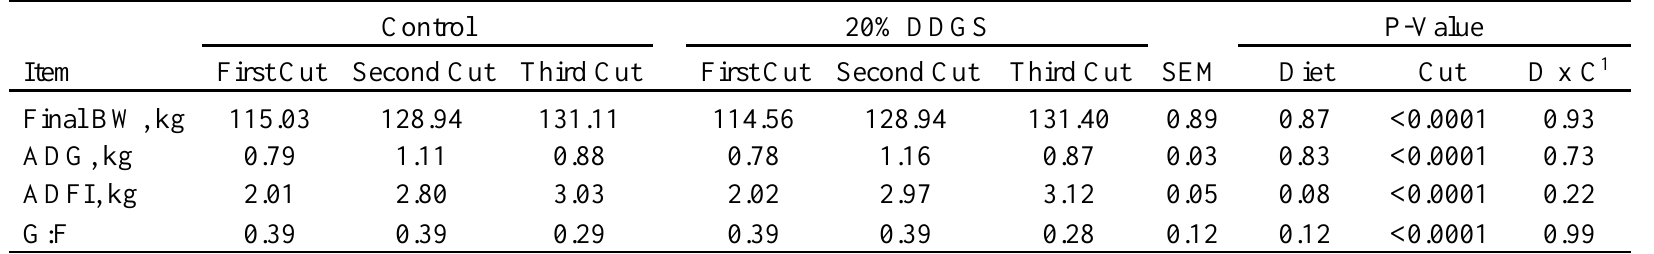
Table 3 . Growth performance least squares means of hogs fed 20% DDGS and marketed in three